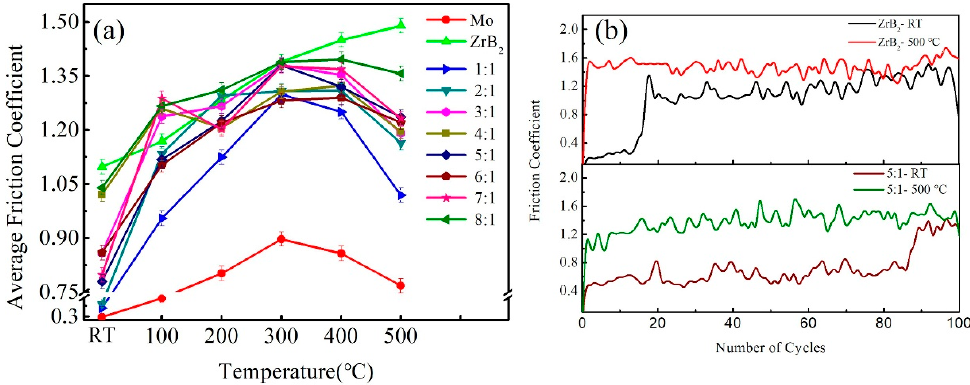
Figure 2. Average friction coefficients ( a ) of ZrB 2 and Mo monolayers and ZrB 2 /Mo multilayers at different temperatures. The friction coefficient curves ( b ) of ZrB 2 and ZrB 2 /Mo ( t ZrB2 :t Mo = 5:1) at room temperature and 500 °C.